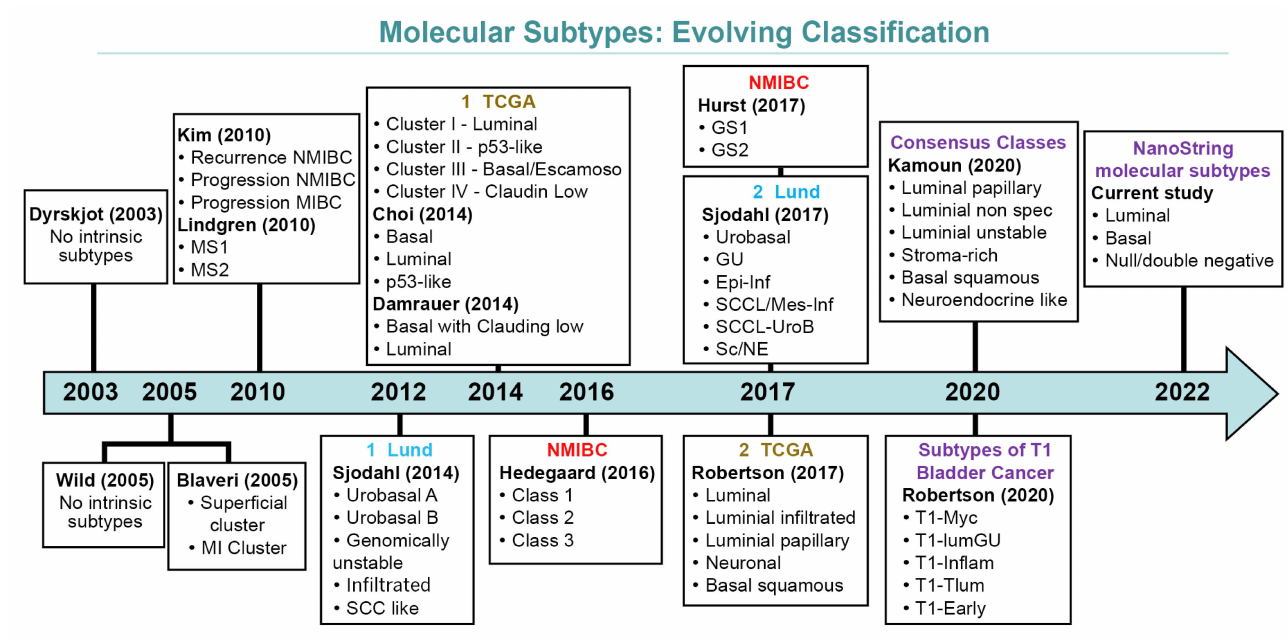
Figure 1. Evolving schemes of molecular classification of urothelial carcinoma of the